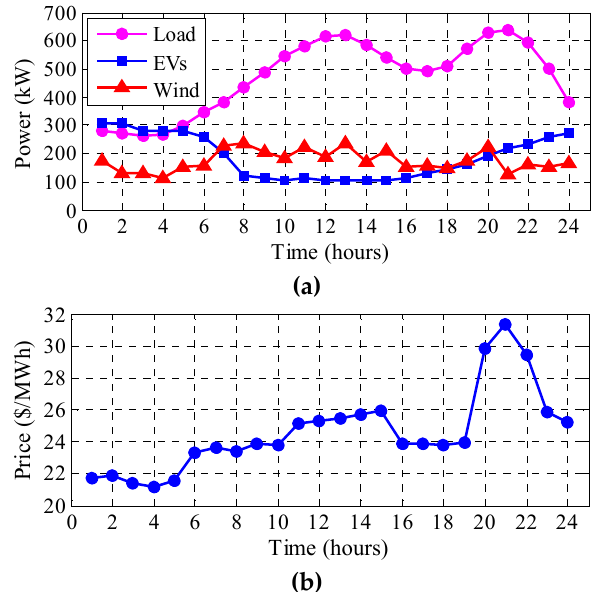
Figure 3. The hourly forecasted values of ( a ) customers’ loads, charging demand of electric vehicles (EVs) and wind power and ( b ) day ‐ ahead (DA) electricity price.